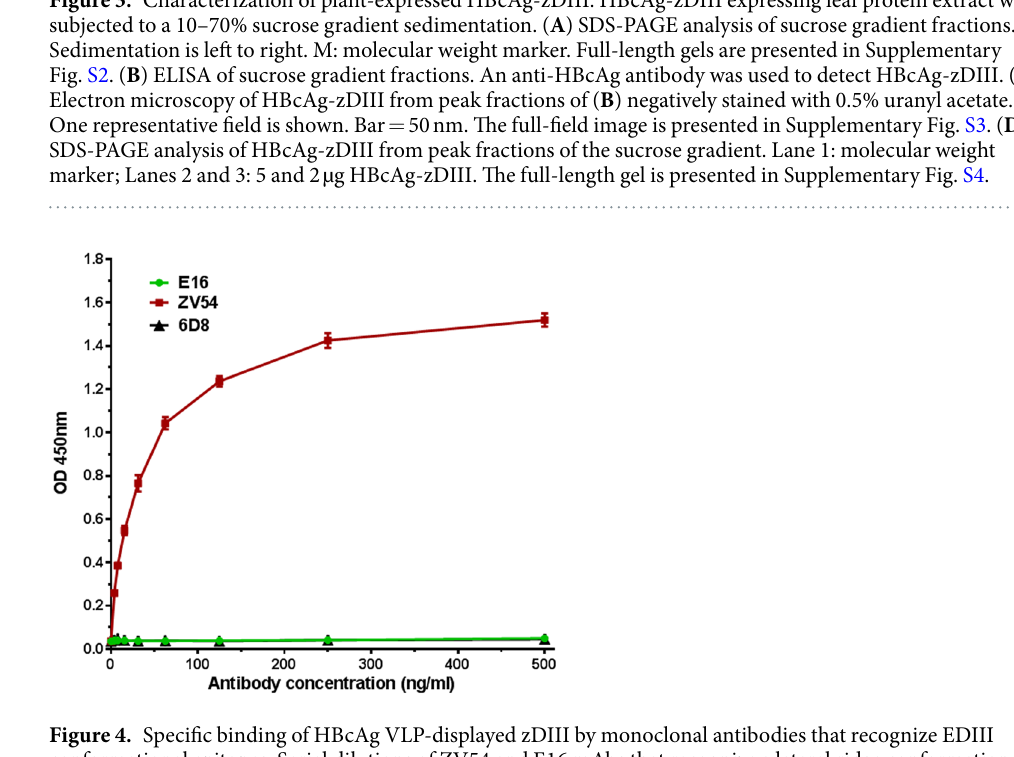
Figure 4. Specific binding of HBcAg VLP-displayed zDIII by monoclonal antibodies that recognize EDIII conformational epitopes. Serial dilutions of ZV54 and E16 mAbs that recognize a lateral ridge conformational epitope on EDIII of ZIKV and WNV, respectively, were incubated in microtiter wells coated with HBcAg-zDIII VLPs and detected with an HRP-conjugated goat anti-mouse IgG antibody. 6D8: an anti-Ebola isotype negative control mAb. Mean ± SD of samples from three independent experiments is